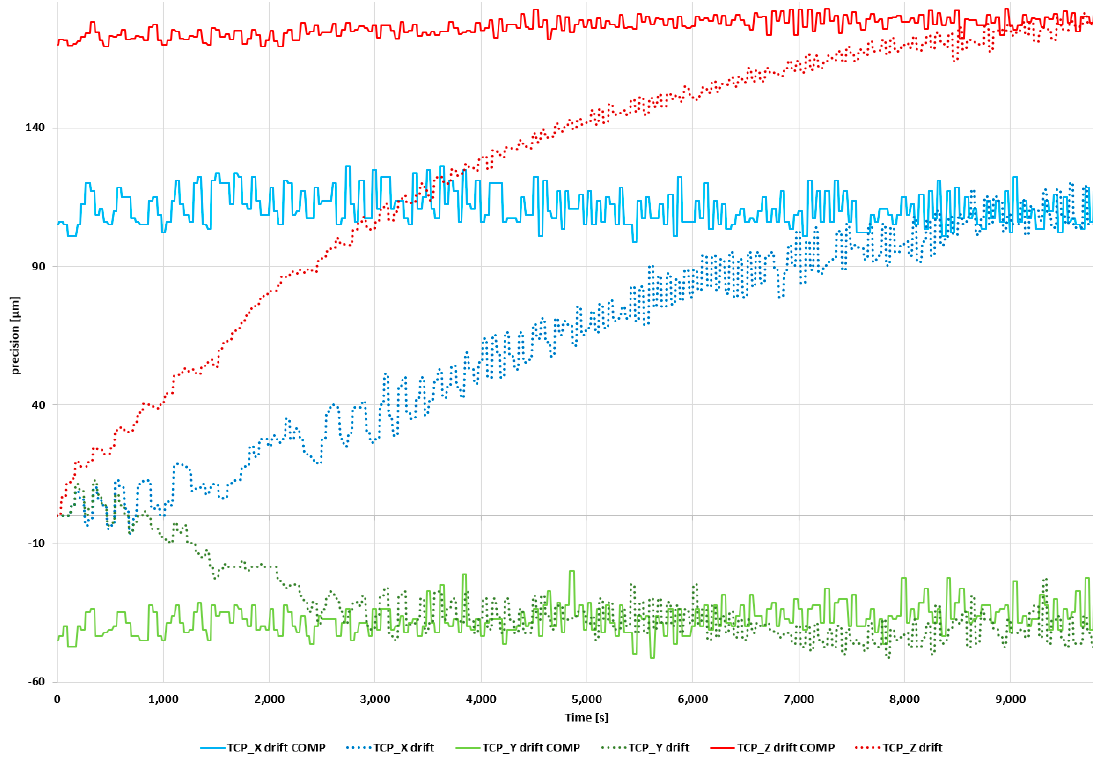
Figure 12. Target 5, working speed, 3DOF repeatability comparison. Blue dots—TCP X not compensated, blue line—TCP X compensated, green dots—TCP Y not compensated, green line—TCP Y compensated, red dots—TCP Z not compensated, red line—TCP Z compensated.